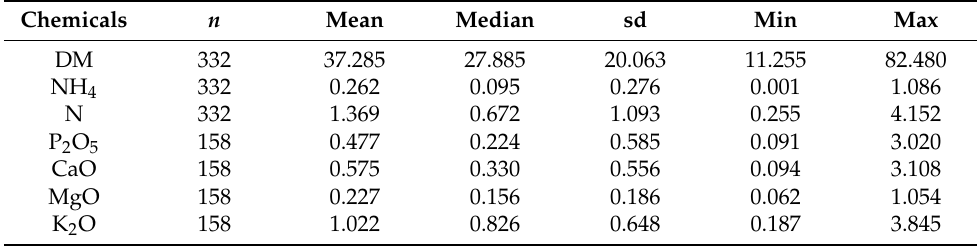
Table 1. Descriptive statistics of the chemical components of poultry and cattle manure in fresh-weight basis (%) ( n = number of samples, sd = standard deviation, min = minimum value, max = maxi- mum